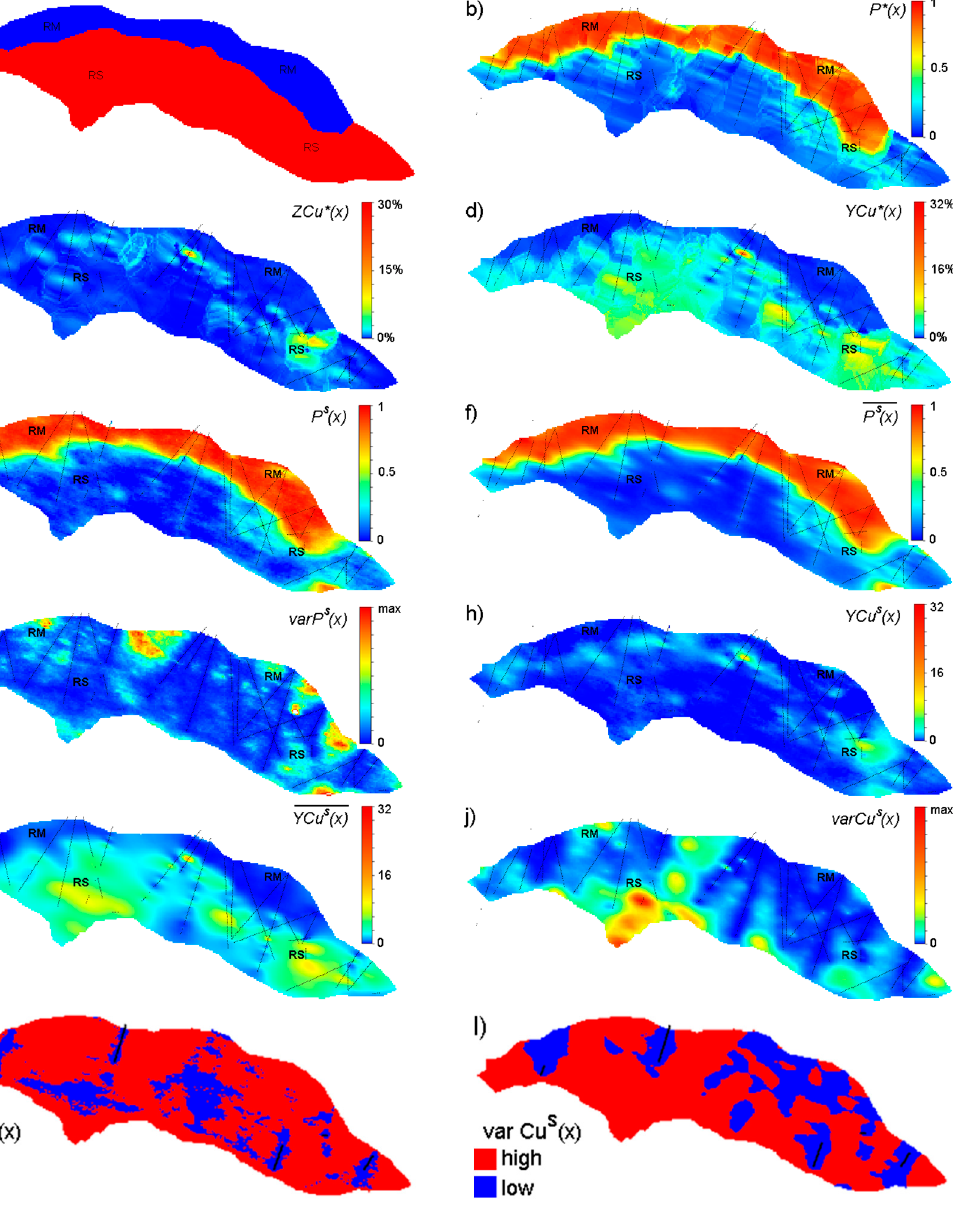
Figure 7. Results in an intermediate cross-section: ( a ) RM (in blue) and RS (in red) regions according the 3D solid model; ( b ) kriging estimated image of P ( x ); ( c ) kriging estimated image of Z Cu ( x ); ( d ) kriging estimated image of Y Cu ( x ); ( e ) one of the thirty simulated images of P ( x ); ( f ) average image of P ( x ) calculated from simulations; ( g ) image of variance (uncertainty) calculated from the set of simulated images of P ( x ); ( h ) one of the ninety simulated images of Y Cu ( x ); ( i ) average image of Y Cu ( x ) calculated from simulations; ( j ) image of variance (uncertainty) calculated from the set of simulated images of Y Cu ( x ); ( k ) binary image of variance (uncertainty) identifying the 25% of blocks with lower local variance calculated from the set of simulated images of P ( x ); ( l ) binary image of variance (uncertainty) identifying the 25% of blocks with lower local variance calculated from the set of simulated images of Y Cu ( x ).